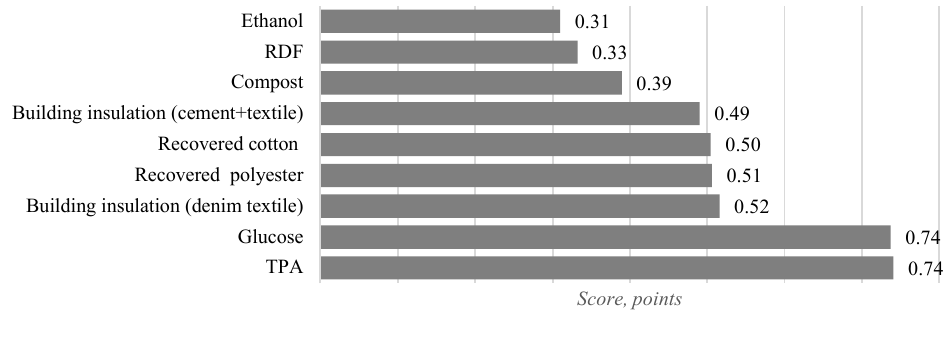
Fig. 5. Decision-making results for textile waste recovered products via MCDA AHP-TOPSIS method (0 – the lowest score, 1 – the highest